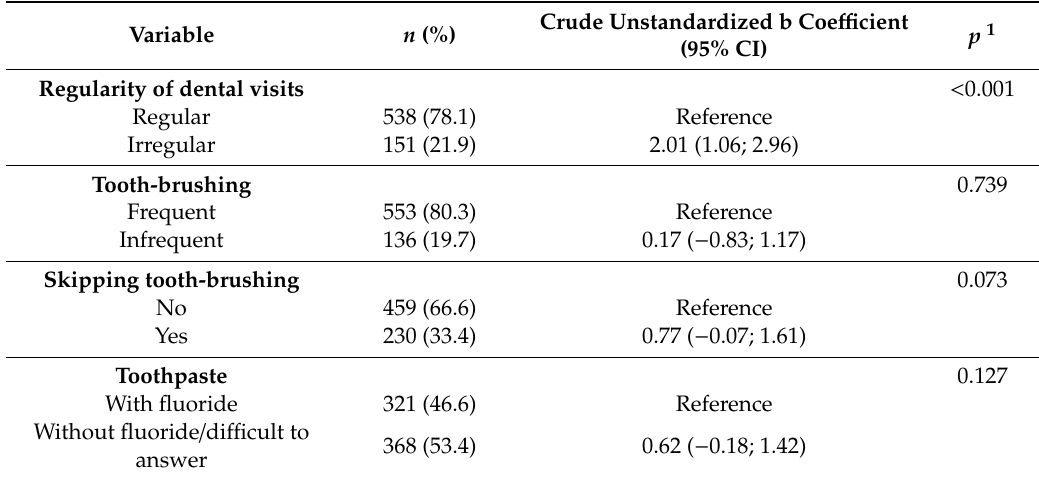
Table 2. Oral health behavior associated with perceived stress in the study sample.